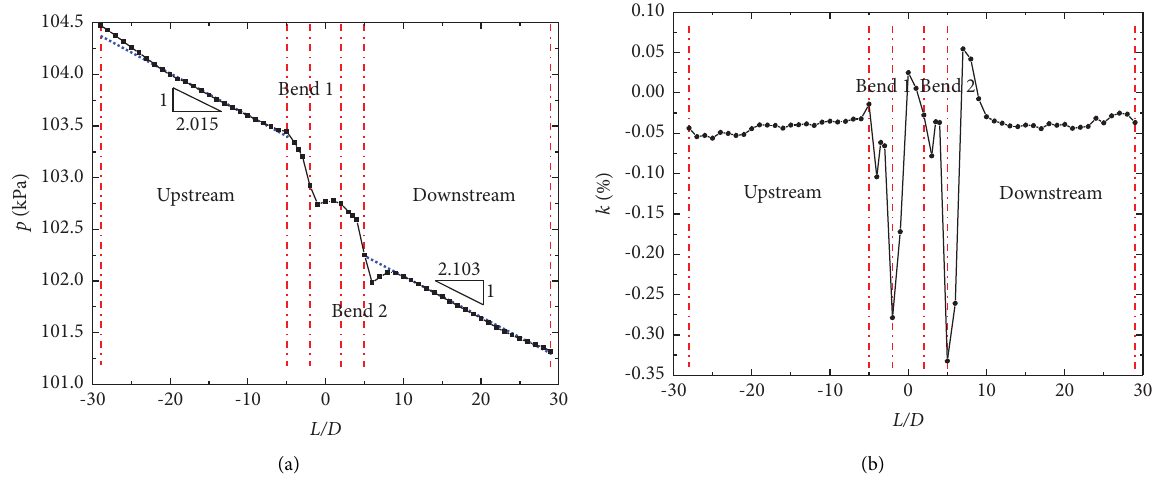
Figure 6: Pressure distribution characteristic curves along the horizontal Z-shaped pipe. (a) Pressure distribution curves along the pipe from the inlet to the outlet and (b) the change rate of pressure along the pipe from the inlet to the